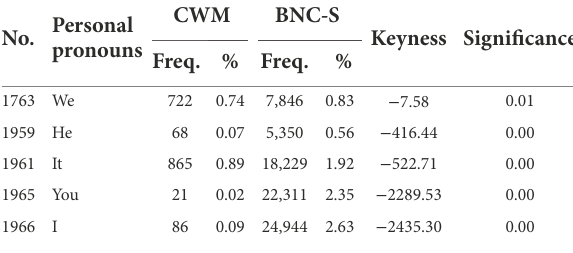
Keyness Significance